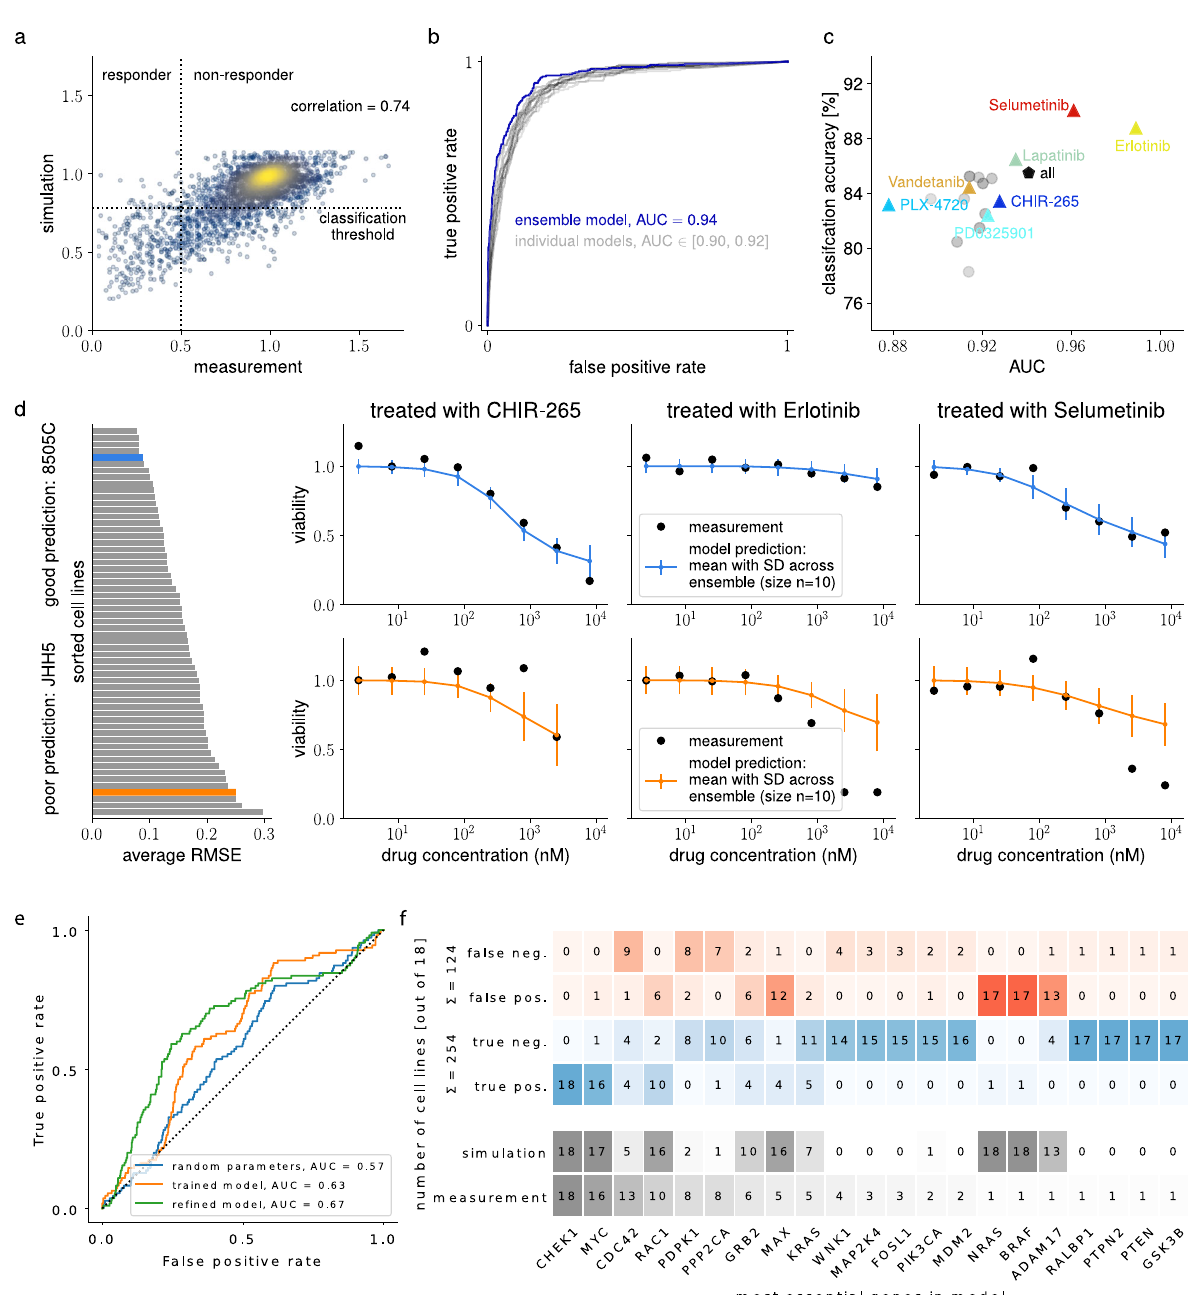
Fig. 5 Validation of the fi tted large-scale cancer model on independent test data. a Correlation of test data and model prediction. Color-coding indicates density in a scatter plot. b ROC curves for classi fi cation of drug responses of cell lines on the test set. Classi fi cation thresholds from the training data were used. c Area under ROC and classi fi cation accuracy on test data for the ten best optimizations (gray), the ensemble model (black), and the ensemble model for each drug individually (colored). d Simulated drug response. Left: Ranking of fi t quality for cell lines by average root-mean-square error. Right: Two out of 59 cell lines from the test data, error bars indicate the standard deviation across an ensemble of the n = 10 best optimization runs, for a cell line which the model was able to describe well (blue, 8505C) and a cell line, which was less well captured by the model (orange, JHH5). e ROC curves for classi fi cation of gene essentiality. Measurement data for 18 cell lines were taken from Behan et al., 2019. In silico knockouts are shown for the untrained model (blue), the trained model (orange), and the re fi ned and trained model (green). f Measurement, prediction, and confusion matrix for essential genes for the re fi ned and trained model. Numbers indicate how often a gene was found to be essential in experimental data and in silico knockout predictions for the 18 cell lines, sums show the number of true and false predictions over essential “ essential ” for a cell line, if the knockout led to a viability parameters as reference. We obtained better-than-random pre- reduction of more than 50% and compared this essentiality clas- dictions (AUC of 0.59) from the untrained model and, as expec- si fi cation with in silico knockouts from our application example ted, better predictions for the trained model (AUC of 0.63). (Fig. 5e). We computed receiver-operating characteristics for Yet, the classi fi cation threshold for model simulation chosen by knockout simulations based on our trained model, and on random the ROC analysis was surprisingly high, leading to many false-